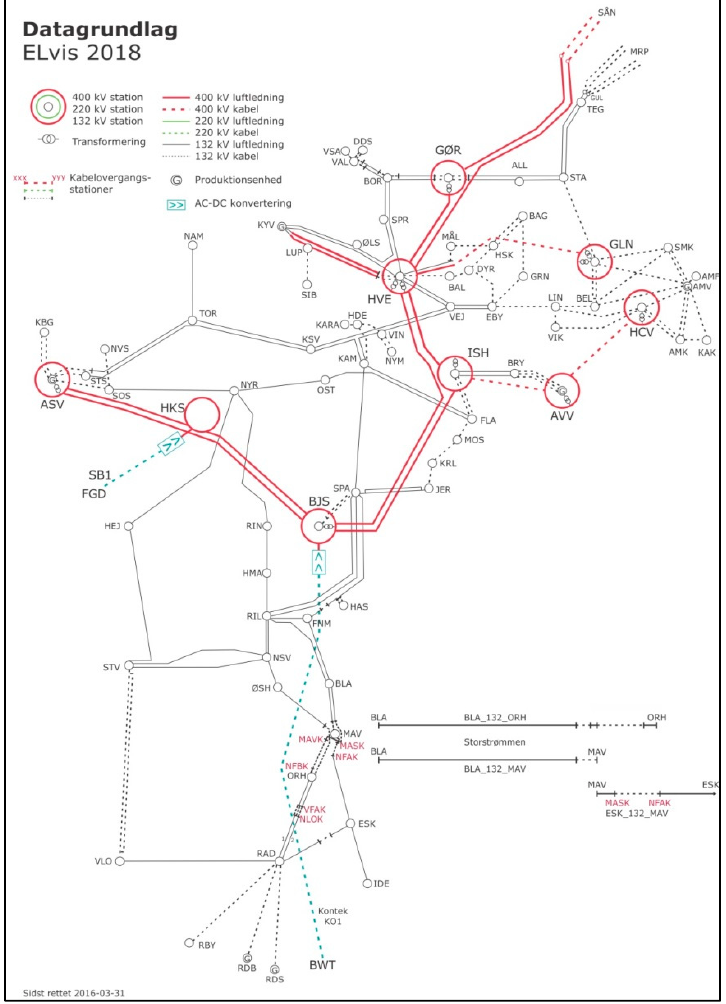
Figure 1. Map of the Danish transmission system, DK2.